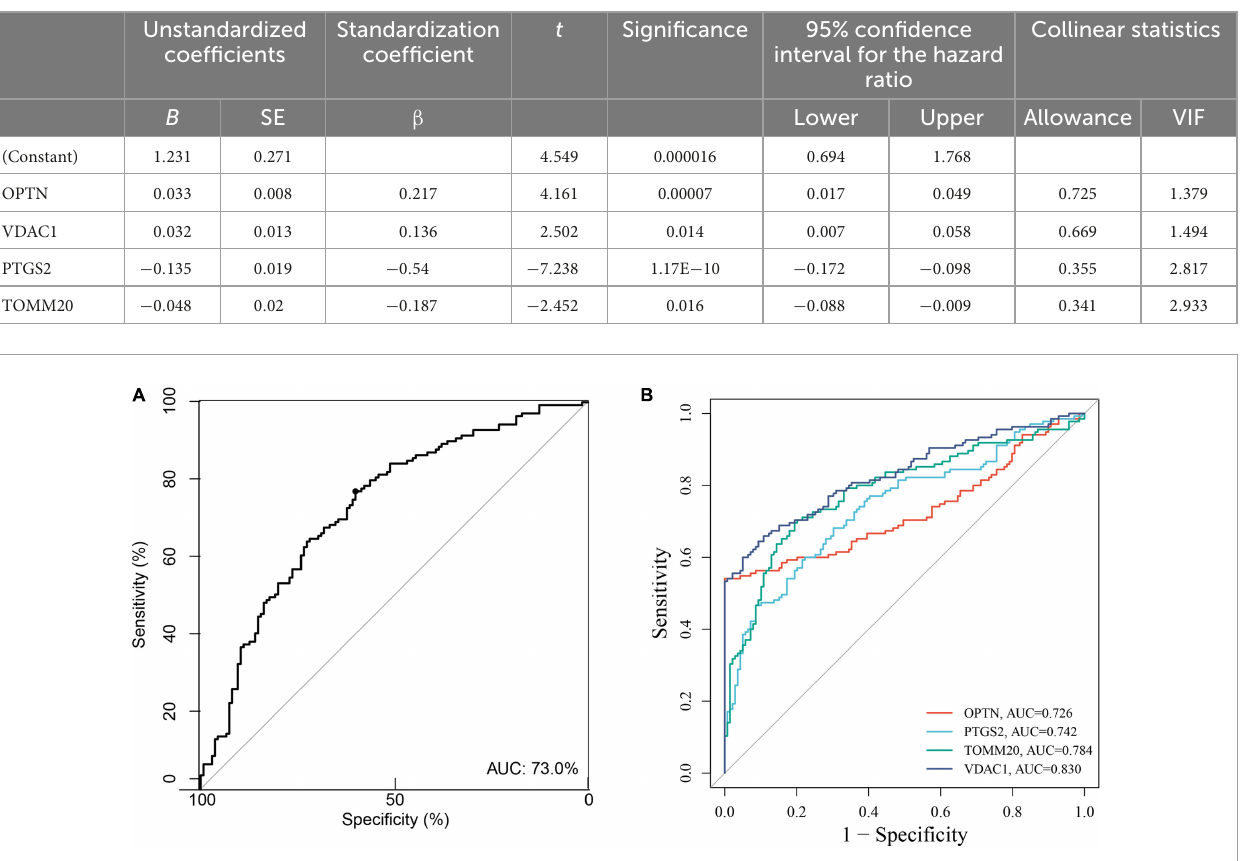
FIGURE7 (A) The ROC verify the feasibility of the diagnosis of nomogram. (B) ROC curve for the four genes in the diagnostic prediction model.